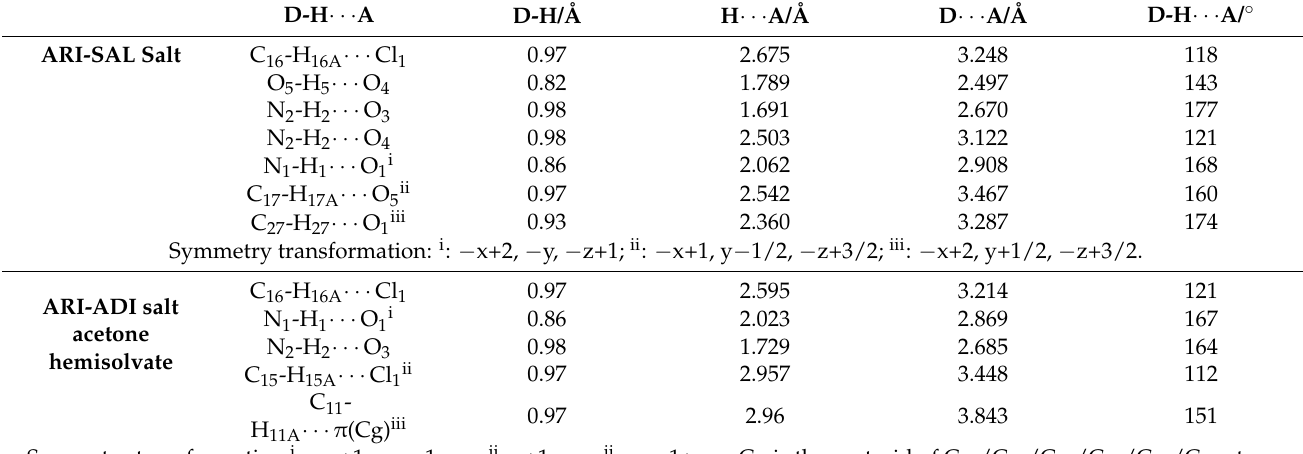
Table 2. Main hydrogen bonding parameters of two multicomponent crystals of ARI.